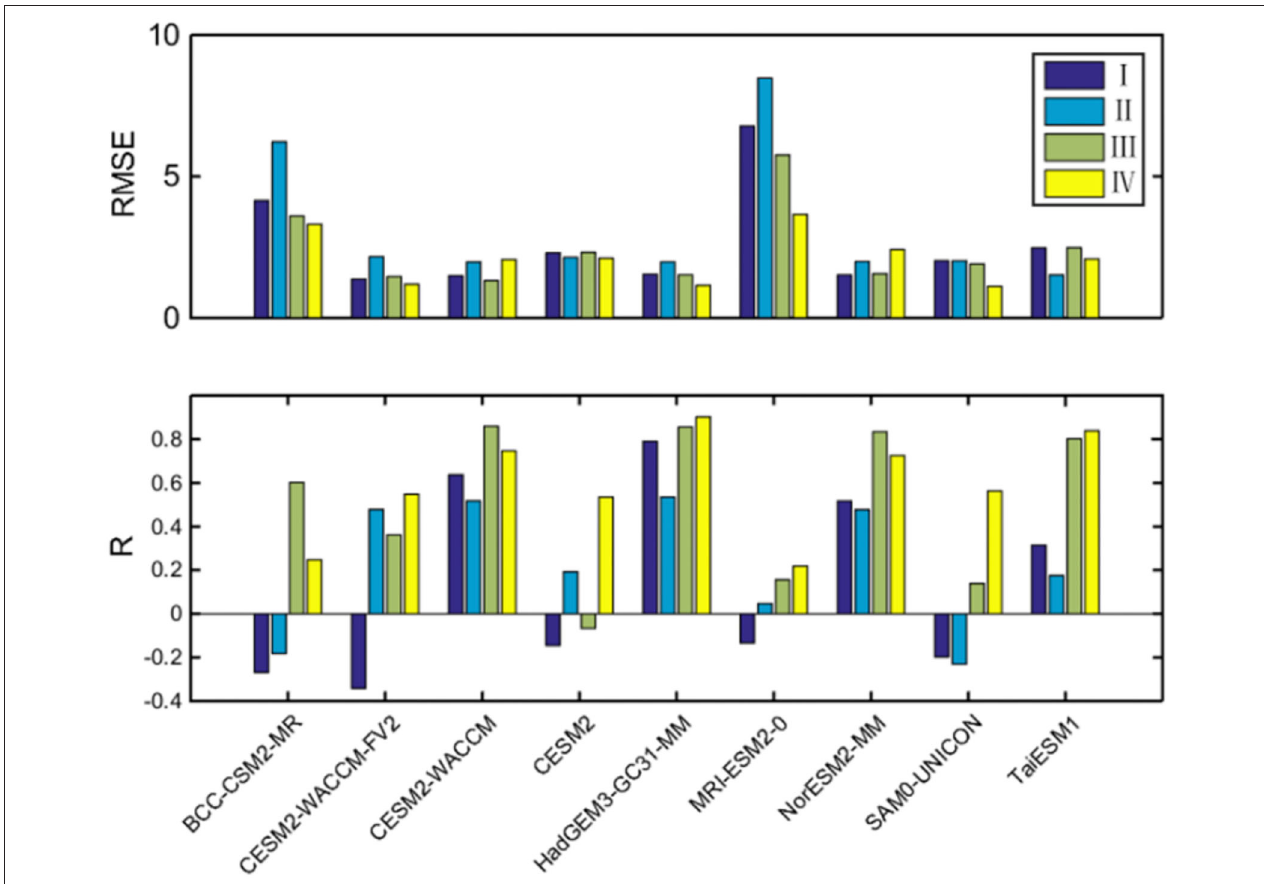
FIGURE 3 | The bar plots of metrics root mean square error (RMSE) and spatial correlation coefficient ( R ). Four different colors represent the four specific regions.